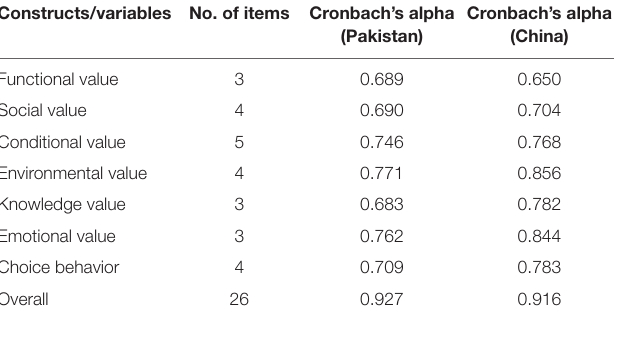
TABLE 3 | Reliability